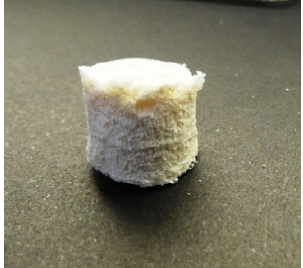
Figure 1 . Scaffold obtained in this study. Figure 1. Sca ff old obtained in this study.